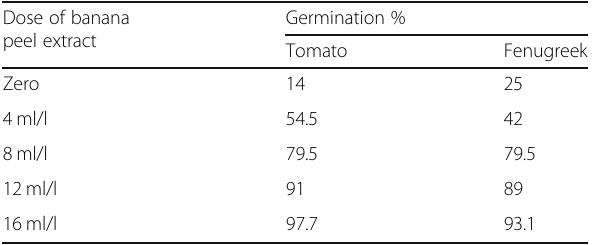
Table 3 Effect of banana peel extract in nanoform on germination percentage on tomato and